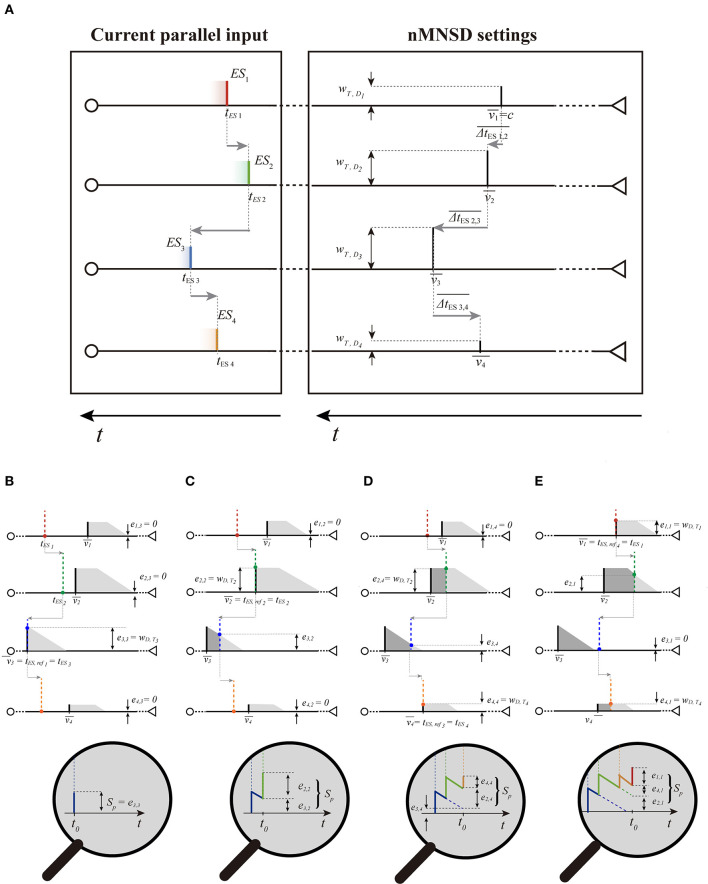
Target summation executed with the trapezoid method. (A) The PPT of a parallel spike train of order 4 (left) moving toward the preferential parallel train (PPT) of the nMNSD settings; the two blocks are here represented separately for ease of understanding. Note that the time axis has to be considered reversed in both the blocks (as in Figure 3), since we are portraying the parallel spike train in motion. Envisaging the parallel train sliding toward right we can notice that ESs will cross the PPT of the structure with the following ES order (i.e., the following crossing order): 〈3, 2, 4, 1〉. In (B–E), we give a “stop-motion” representation of the target summation executed with the trapezoid method, showing both the parallel spike train and the trapezoid set of the structure on the same chart (with related zoomed representation of ST below). Except for the trapezoid associated to the first crossing step (which always lacks the rectangle part, as explained in the text), a generic trapezoid has the rectangle length determined by the time difference between its arrival and the end of the trapezoid associated to the last contribution arrived to the target; once the rectangle parts have been drawn, the triangle parts can consequently traced to the right of the rectangle parts to obtain the complete trapezoids. Using the trapezoid method, the efficacies ei, refk to the state of the target neuron ST are directly noticeable on the input of the structure, since they are represented by the heights of the intersections between the ES and the upper perimeter of the related trapezoid (colored dots). At this point, the summation can be easily decomposed in the contribution of each branch. In the zoom below, the reader can ascertain for the first three crossing steps (ref1 = 3, ref2 = 2, ref3 = 4) that the computation of the Sp through the trapezoid method is equivalent to the one obtained by the classical target summation at the target neuron.